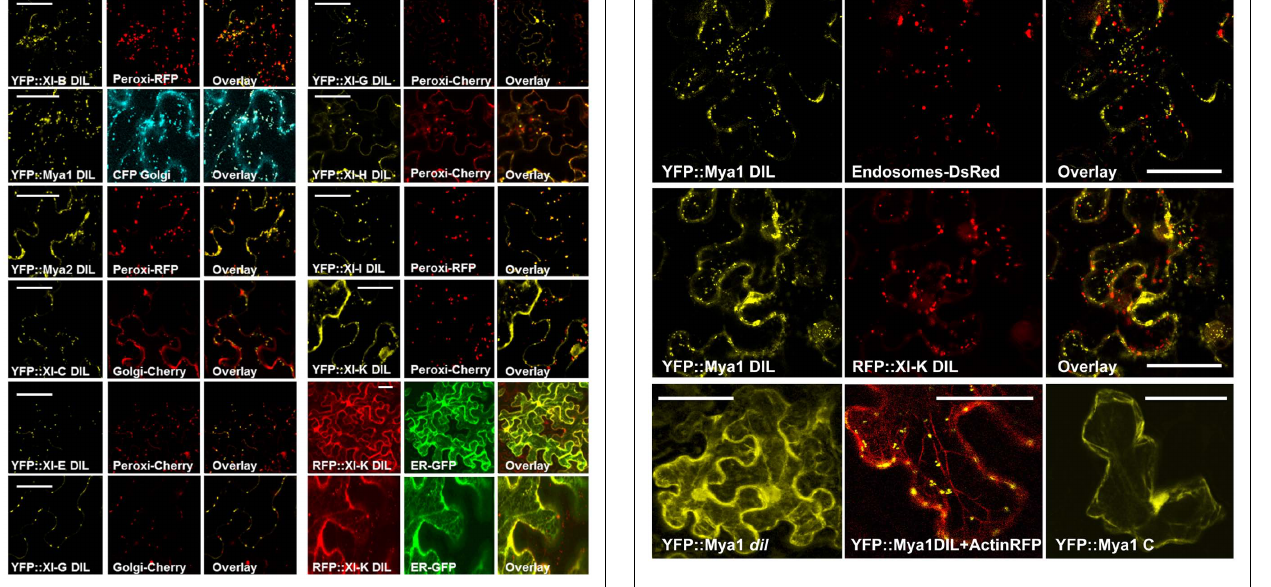
FIGURE 5 | Co-expression of theYFP::Myosin Mya1 DIL domain with DsRed marker for endosomes, RFP::XI-K DIL domain and RFP marker for actin in epidermal leaf cells of N. benthamiana .Transient expression ofYFP::Mya1 dil (see Table 1 ; Figure 2 ) in comparison to expression of YFP:: Mya1 C (1438–1520 a.a) in epidermal leaf cells of N. benthamiana . Scale bar = 50 μ m.